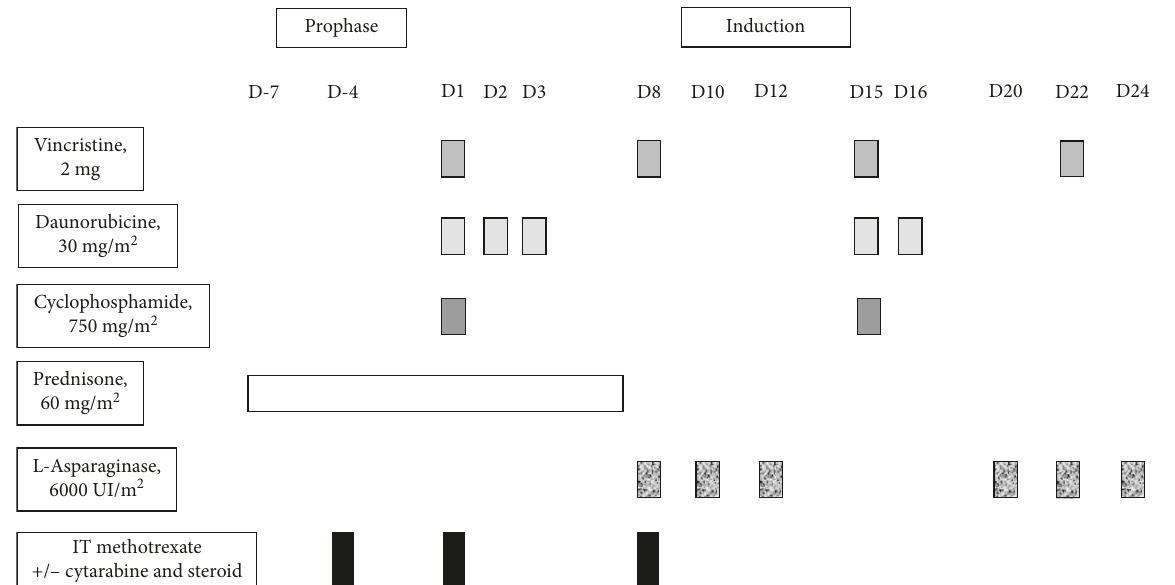
Figure 1: Prophase and induction phase of the GRAALL-2014 protocol for patients aged